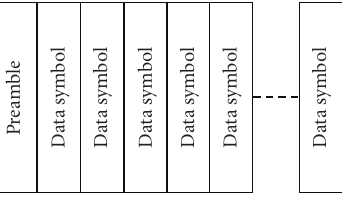
Figure 2: Basic transmission frame.